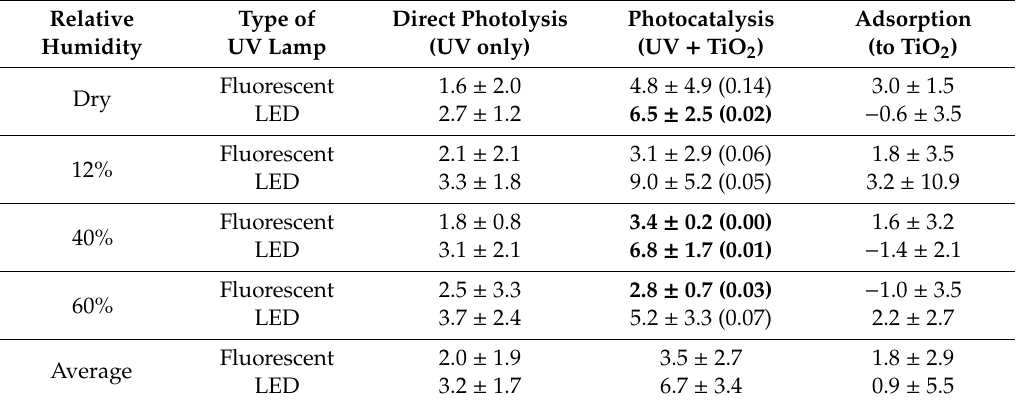
Table A6. N 2 O mitigation under di ff erent light types and relative humidity at a treatment time of 40 s. Values in the table report % reduction ± standard deviation ( p -value) and are an average between treatments of NH 3 and H 2 S standard gases. Bold font signifies statistical significance.